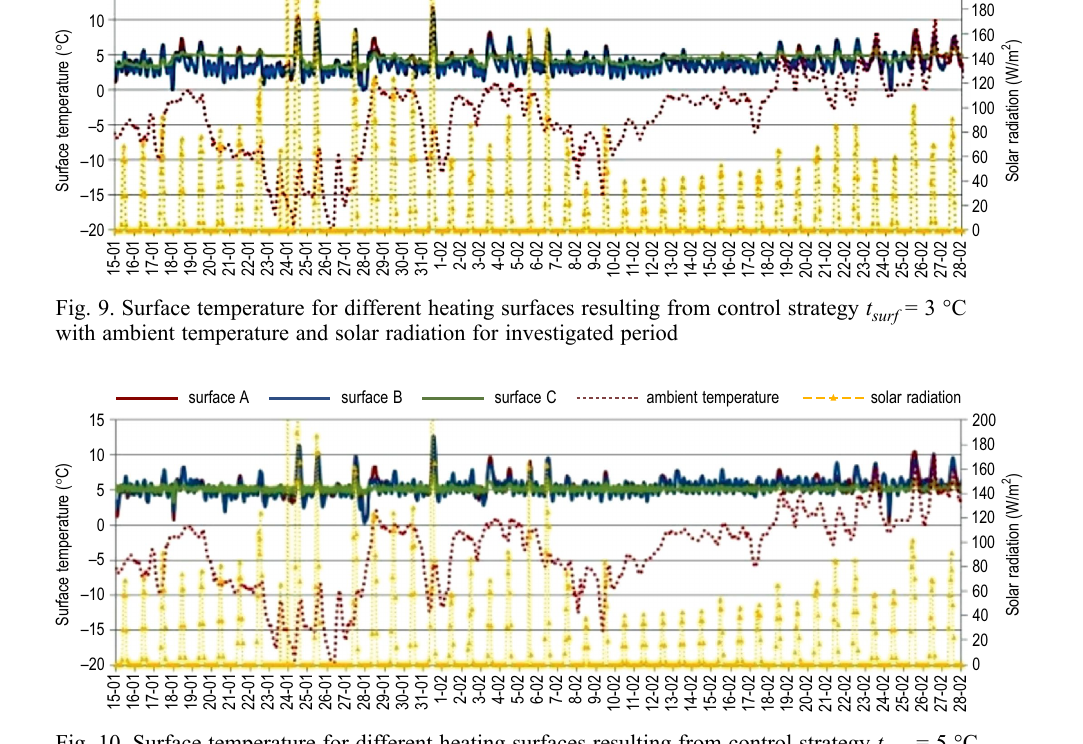
Fig. 10. Surface temperature for different heating surfaces resulting from control strategy t surf = 5 °C with ambient temperature and solar radiation for investigated period